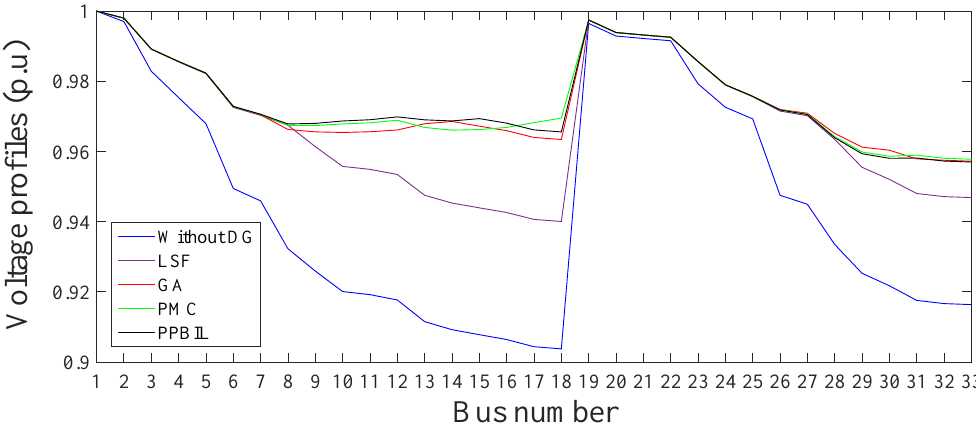
Figure 13. Voltage profiles of the test system with 33 buses.